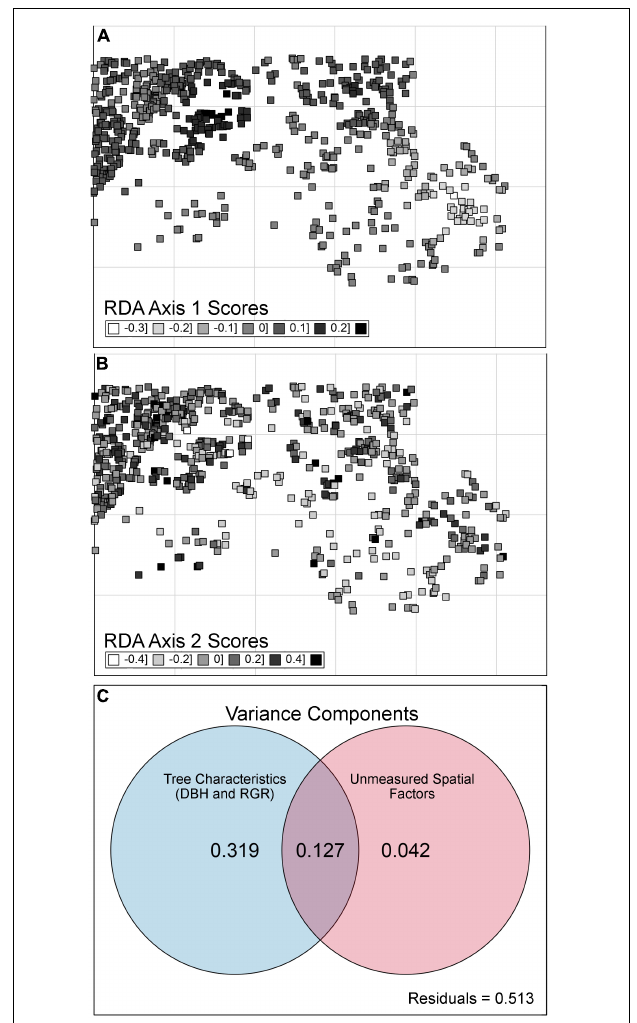
FIGURE 4 | Spatial patterns and variance partitioning analyses for beech bark disease (BBD) severity rankings across a temperate forest site. Spatial patterns in BBD are presented as the first [Panel (A) ] and second [Panel (B) ] axes for a constrained principal components analysis (CCA), evaluating BBD severity as a function of five statistically significant eigenfunctions retained through a forward stepwise selection process (where adjusted r 2 of CCA = 16.8%). While five eigenfunctions were retained, following a gradient of fine to coarse scale structure, only two are shown here. The Venn Diagram [Panel (C) ] shows the unique and shared proportions of variation in BBD severity rankings captured by the tree-level characteristics [tree diameter (DBH) and relative growth rate (RGR)] (presented in Figure 2 ; blue circle), as well as spatial structure as per Moran’s Eignevector Maps [MEMs presented in Panels (A,B) , red circle]. Although five MEMs were retained, they contributed little additional unique explanatory power to the overall model of BBD